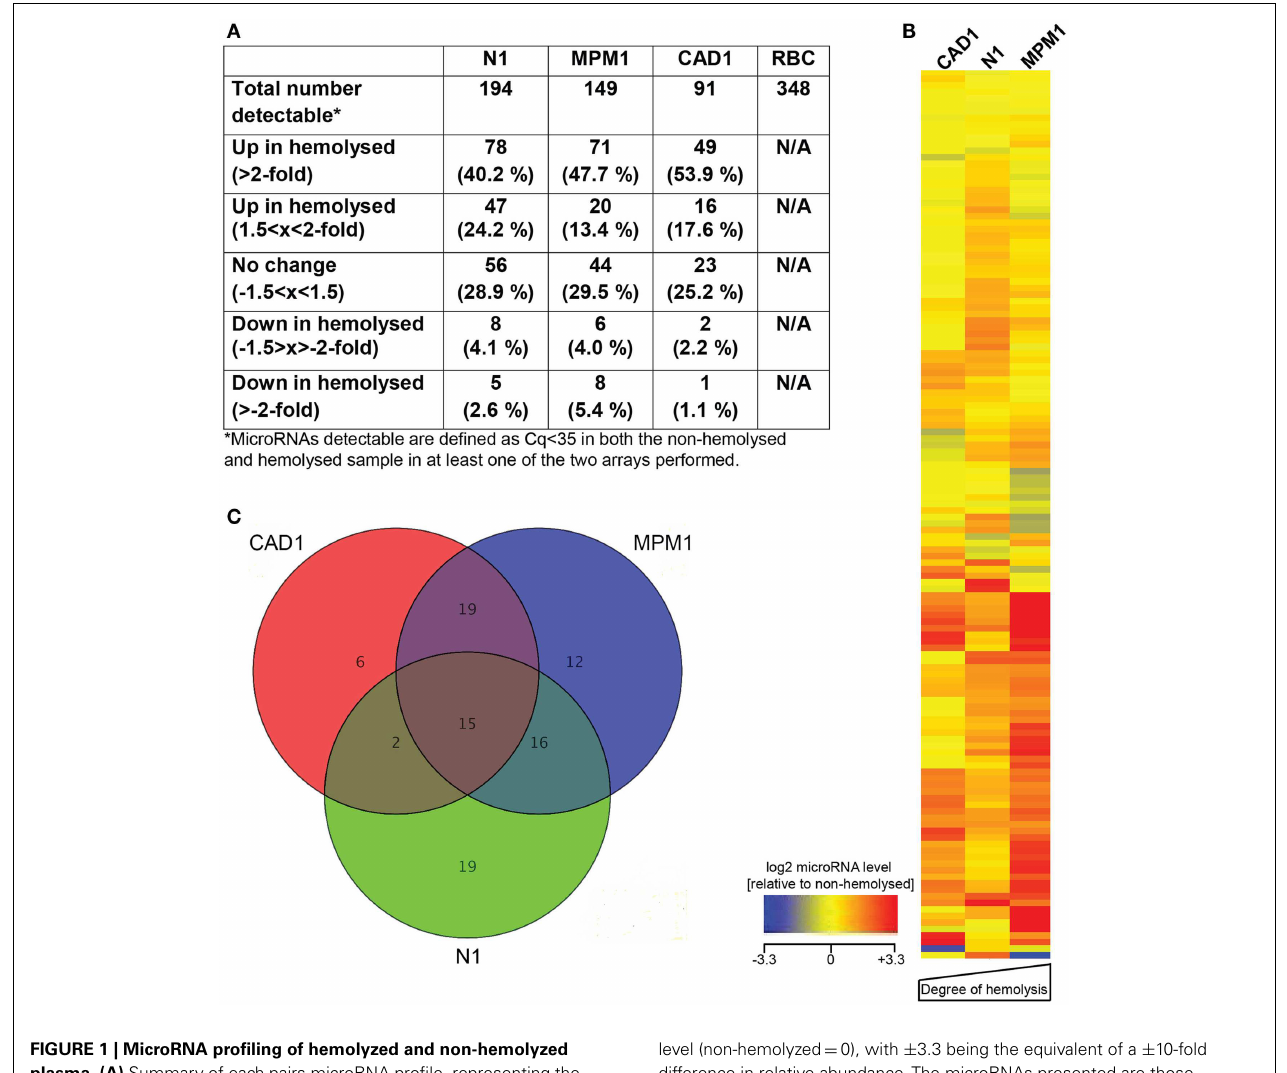
FIGURE 1 | MicroRNA profiling of hemolyzed and non-hemolyzed plasma . (A) Summary of each pairs microRNA profile, representing the total number of microRNAs detectable as well as numbers of microRNAs affected or unaffected by hemolysis in each pair. (B) Heatmap of relative abundance of 136 microRNAs in hemolyzed compared to non-hemolyzed plasma. Levels of microRNAs in hemolyzed samples are presented as log2 of the relative expression